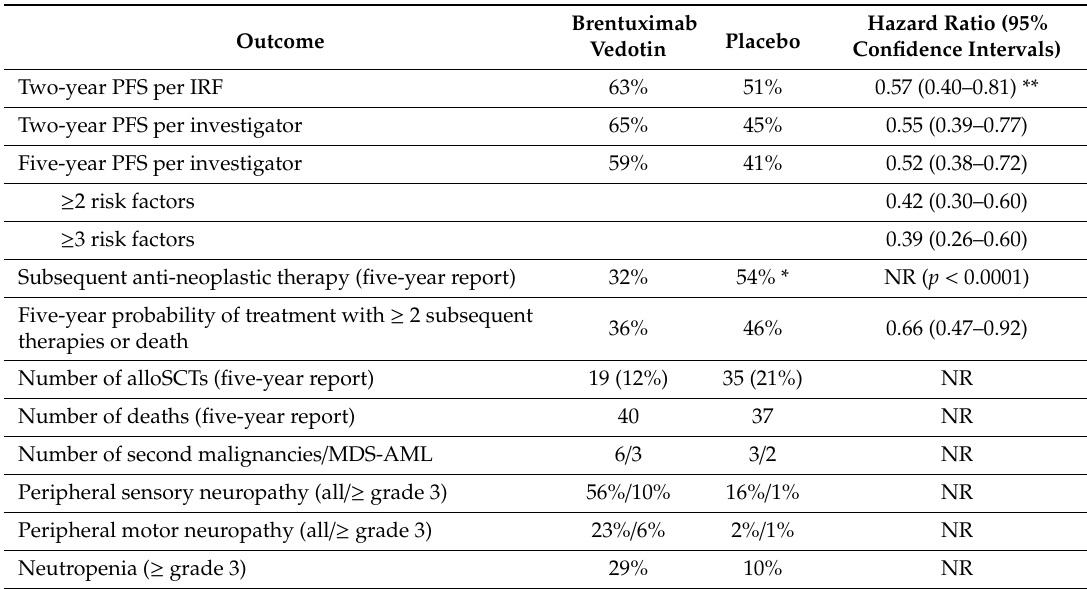
Table 3. Main patient characteristics and outcome measures in the AETHERA trial. Data extracted from references